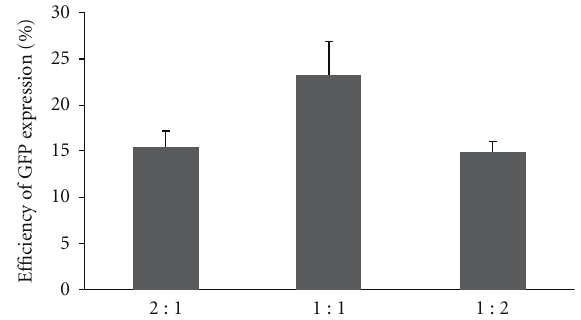
Figure 6: The e ffi ciency curve of GFP expression with di ff erent amounts of nanoparticle/DNA complexes. The e ffi ciency of GFP expression was influenced by the amount of the nanoparticle/DNA complexes. E ffi ciency increased with raised amount of complexes in low range, decreased with continuously increasing the amounts of complexes, and then changed not obviously when the complex amount surpassed 4 µ g.